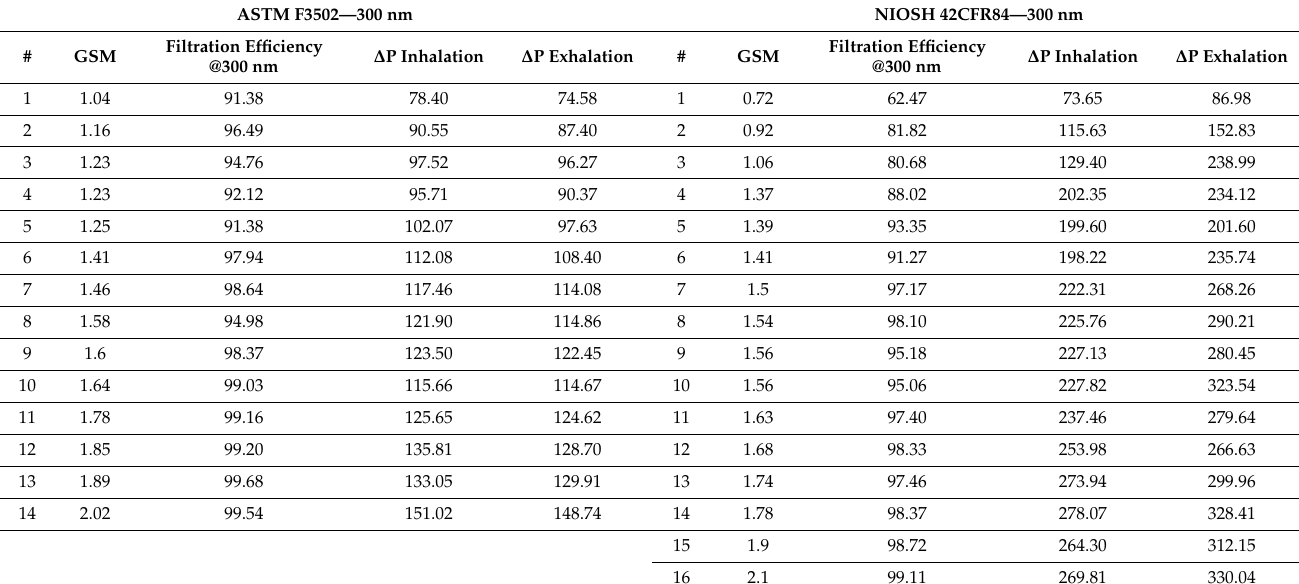
Table 3. Filtration efficiency and pressure drop results across varying aerial weights tested in accordance with ASTM F3502 and NIOSH